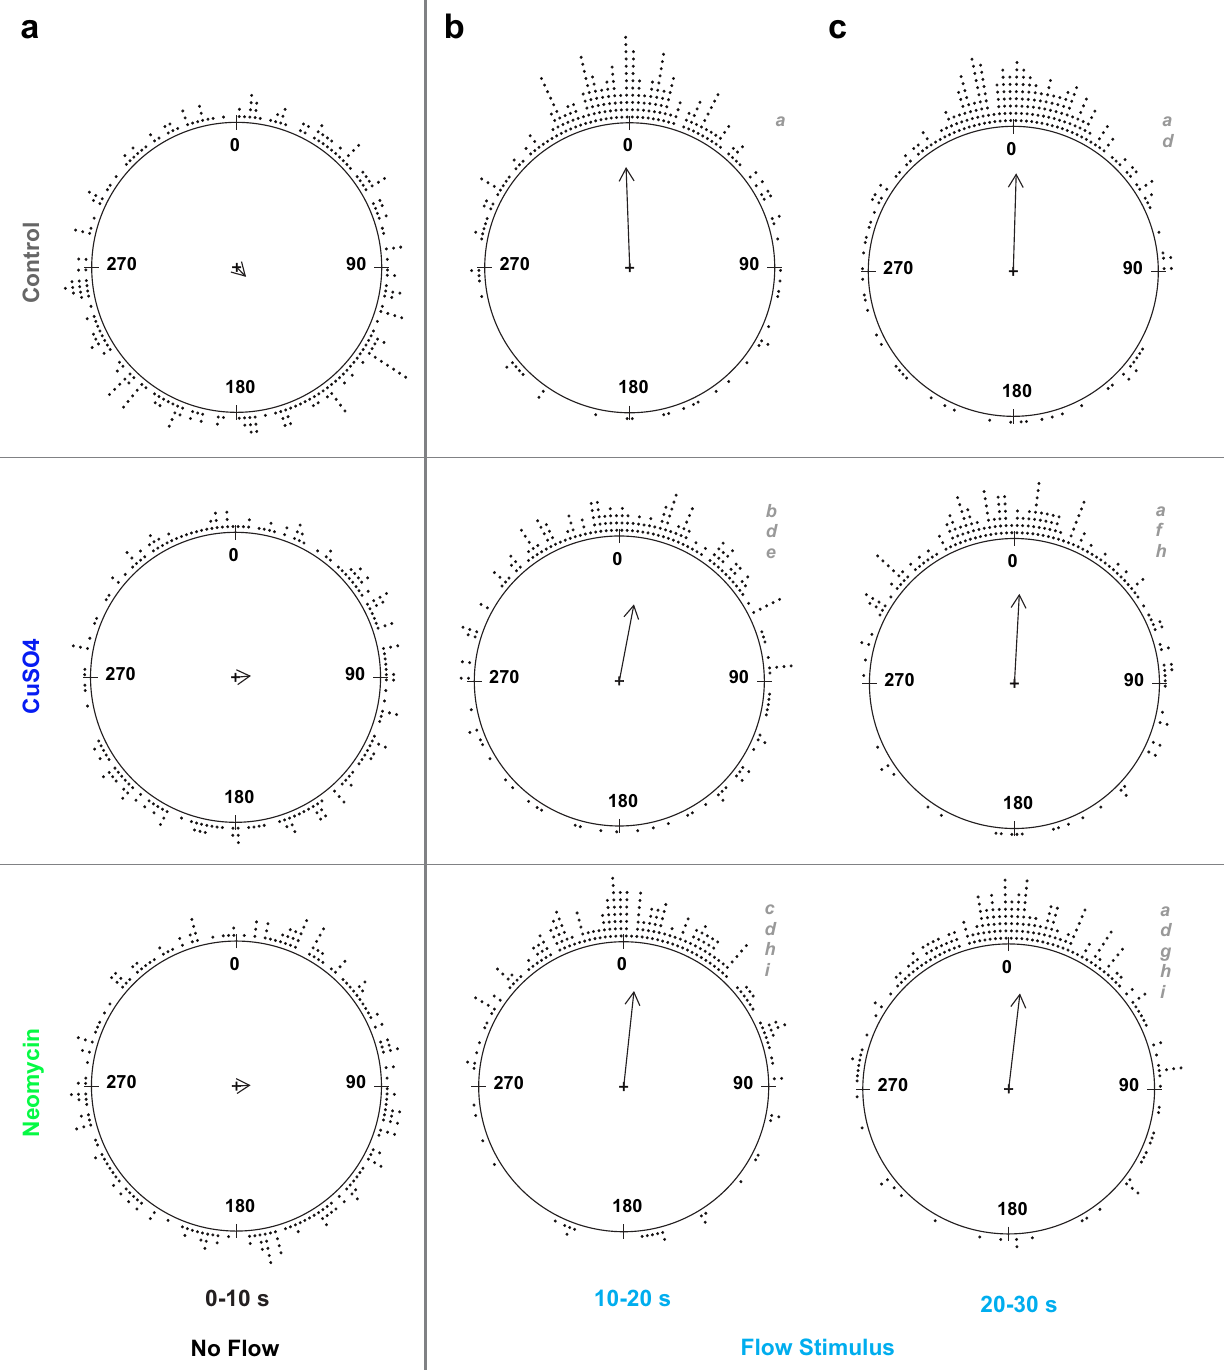
Fig. 3 The mean resultant vectors of fi sh treatment groups before and during water fl ow stimulus indicates fi sh with lateral-line organs ablated by CuSO 4 or neomycin can still perform rheotaxis. a Under no fl ow ( t = 0 – 10 s), groups of lateral line intact (control, n = 248) and lesioned fi sh (CuSO4, n = 204; neomycin, n = 222; 18 experimental sessions) have a random distribution of individual mean body angles. b , c Under fl ow, all groups show a statistically signi fi cant orientation to 0° ± 45°, but the distributions of the individual mean angles within the groups differ between the initial ( b ; t = 10 – 20 s) and fi nal ( c ; t = 20 – 30 s) stimulus bins. Each dot outside the circles represents the mean body angle of an individual fi sh for the 10 s duration of the no fl ow ( a ) and fl ow stimulus conditions ( b , c ). The grand mean vector for each group is represented by a summary vector with an angle, theta , and a mean resultant length, rho , where the length of the vector represents the distribution of individual angles around the mean angle of the group. The length of the vector ranges from zero for uniform distributions, to one for distributions perfectly aligned with the mean angle. Consequently, the angular variance (1- rho ) is inversely related to vector length. Distributions with the same lowercase letter indicate groups that do not differ